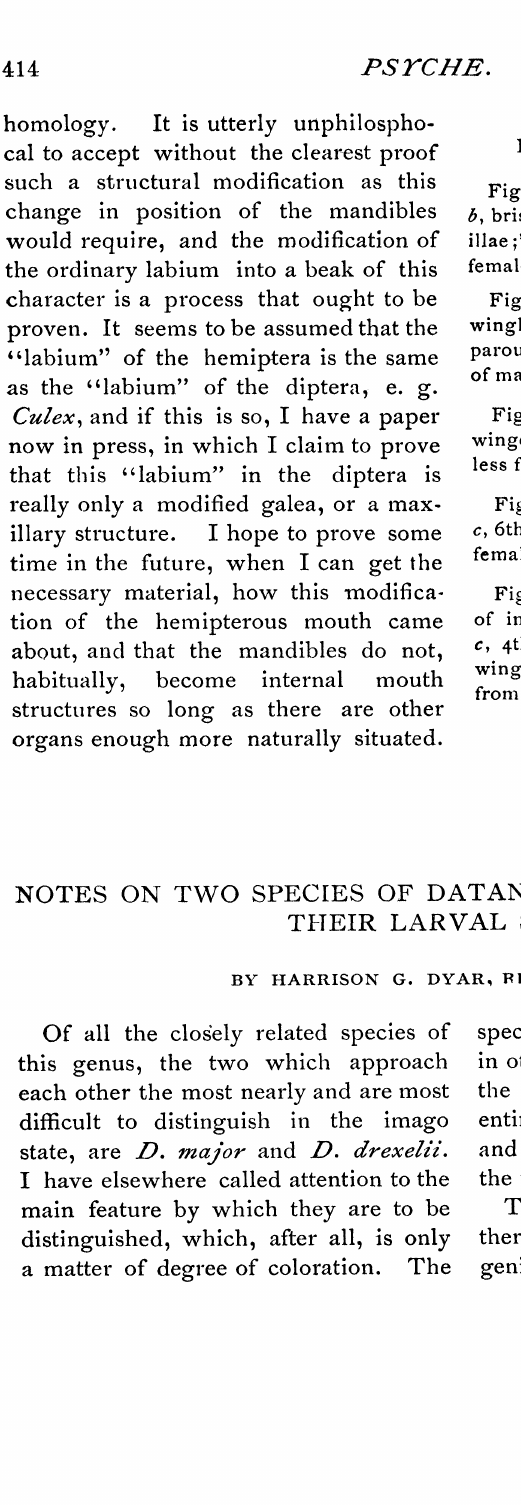
Fig. 3. Ahhis cucumeris, a, antenna of